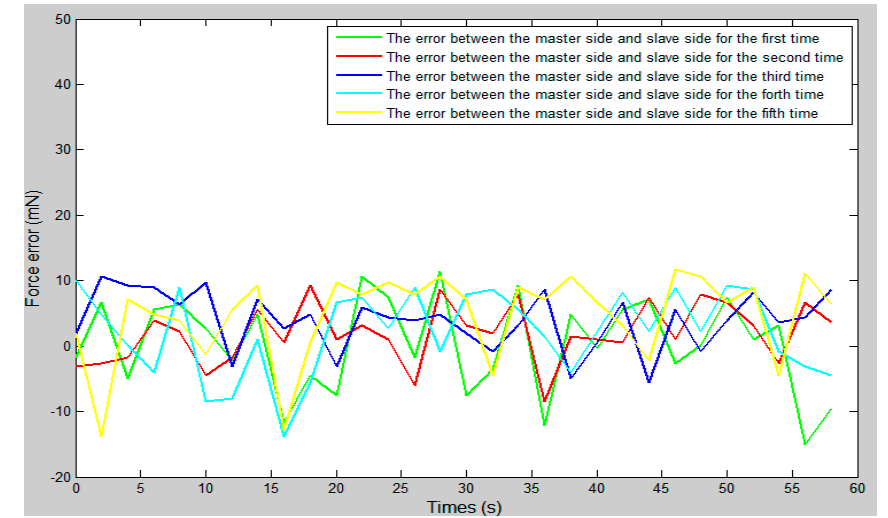
Figure 14. The error curve between the slave detected force with the master feedback force.